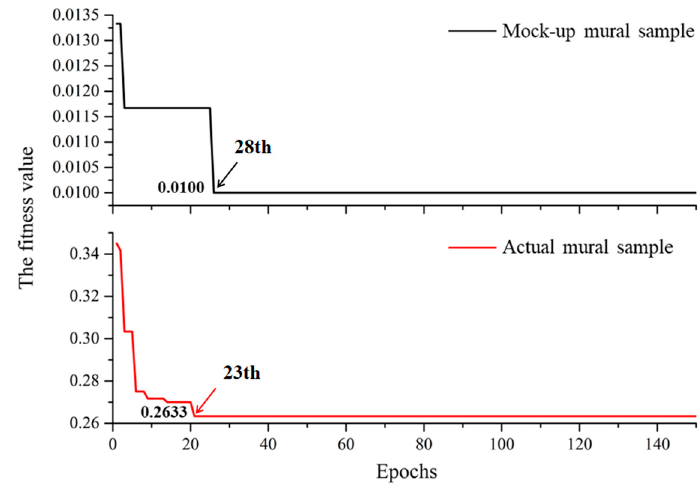
Figure 7. Variation trend of the fitness value with epoch.